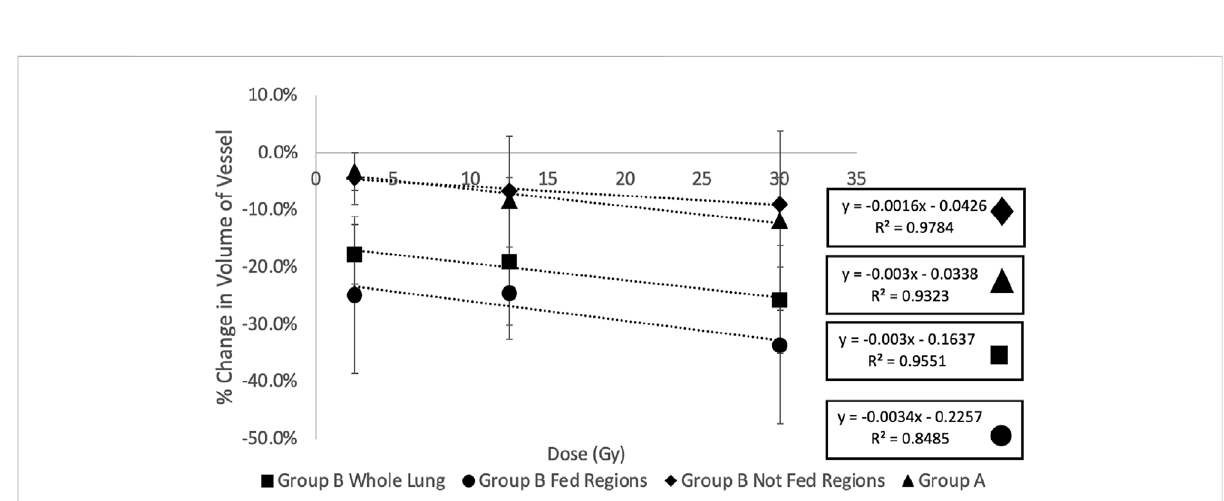
FIGURE 10 Summary of the percent changes in volume of vessel in each of the dose bins for the group (A) swine (all not fed), group (B) swine, and split group (B) swine results masked by being in a fed or not fed region. All data sets show strong linear correlation with dose where the reduction in vascular volume increases with increasing dose. The percent changes in the not fed regions are very similar to the group (A) percent changes while the fed regions show signi fi cantly higher magnitudes of